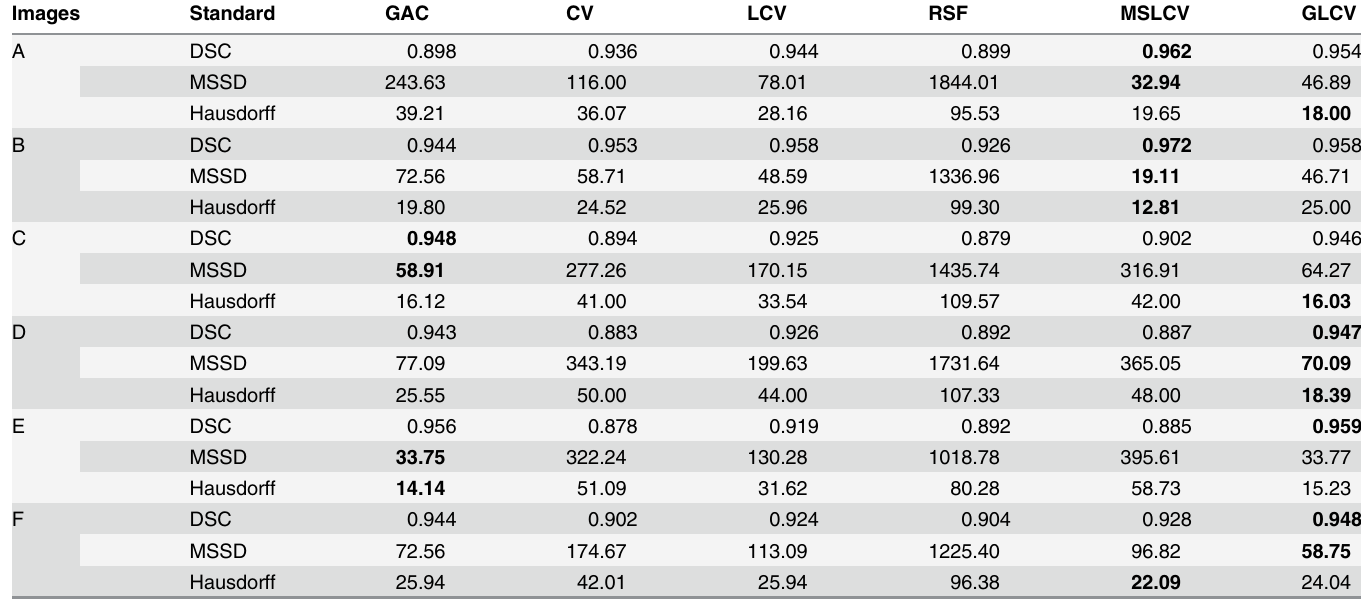
Table 2. Comparison of DSC [36], MSSD [37] and Hausdroff distance [37] by utilizing GAC [19], CV [20], LCV [22], RSF [23], MSLCV [24] and GLCV methods for HIFU ultrasound images segmentation. Images